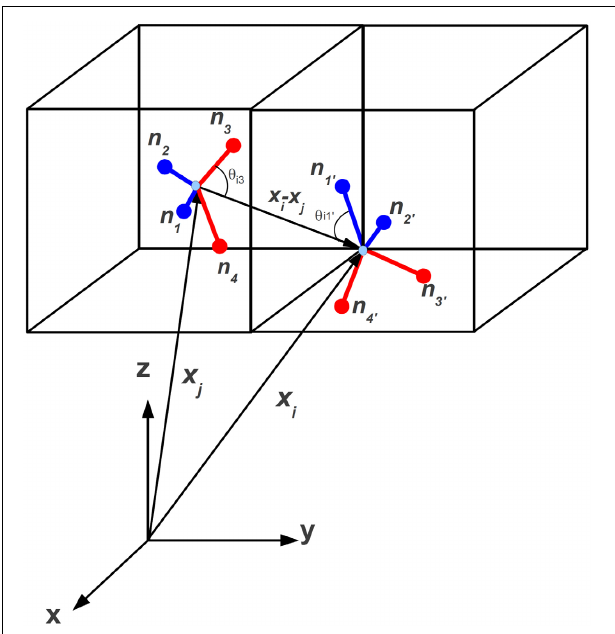
FIGURE 2 | Tetrahedral representation of water-like molecules sitting at lattice site x j and its neighbor x i . The four arms are denoted by the corresponding normals n k , k = 1 , 4 (unprimed) and n l , l = 1 , 4 (primed), respectively. Blue and red code for donor and acceptor arms, respectively. Here the index i corresponds to i = 23 in Figure 1